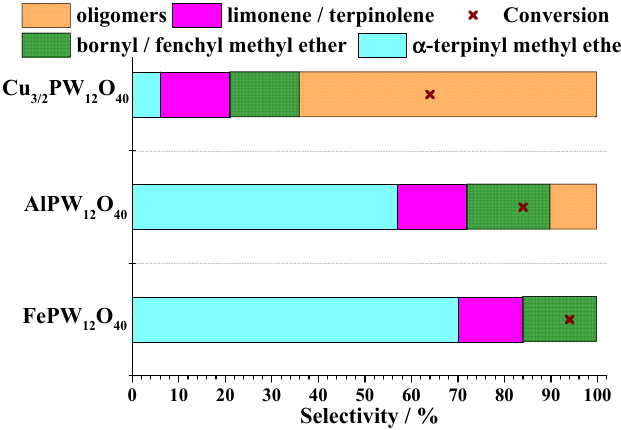
Conversion Figure 10. Impacts of Keggin anion on the conversion and selectivity of Keggin HPA iron salts phos- photungstate-catalyzed reaction of β -pinene with methyl alcohol (adapted from ref. [34]) a . a Reac- tion conditions: β -pinene (3.8 mmol), CH 3 OH (14.3 mL), temperature (333 K), catalyst (0.50 mol%),